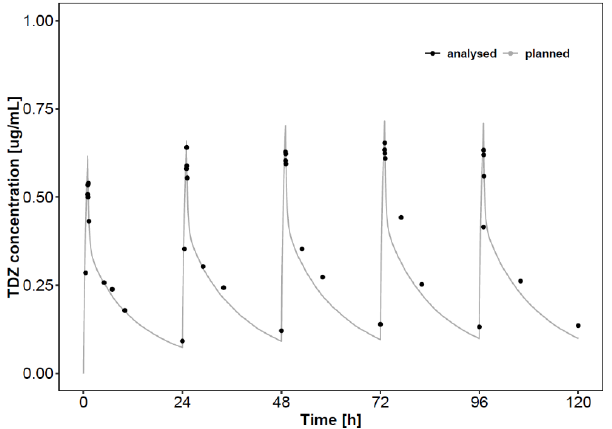
Figure 4. PK results of the HFIM study: concentration time profiles of the planned and analyzed TDZ at a dose of 200 mg/day. TDZ at a dose of 200